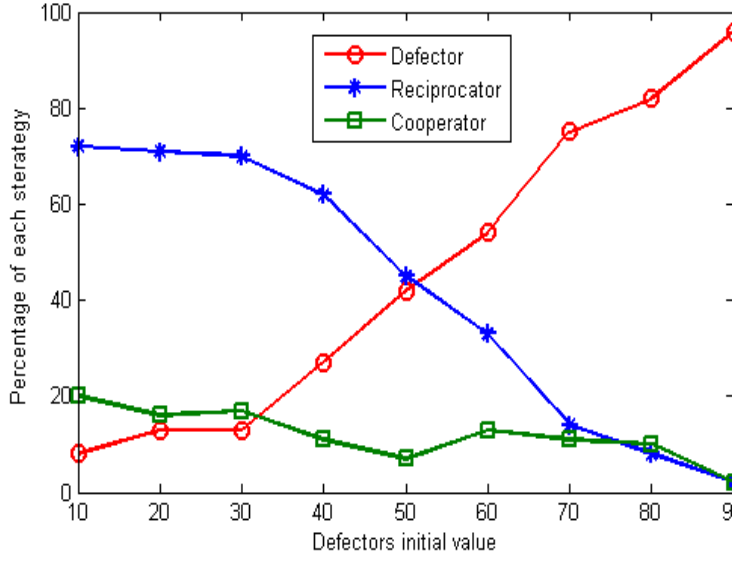
Figure 9. Effect of number of free-rider on